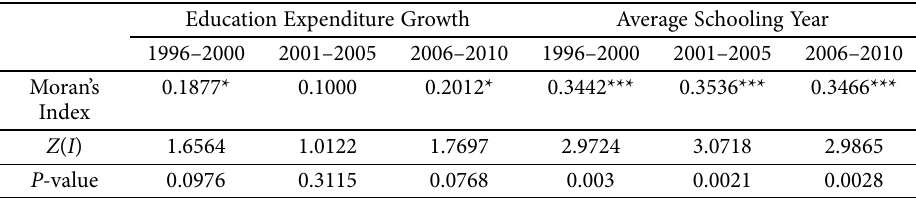
Table 2. Global Moran’s Index of education expenditure growth and average schooling year in China during 1996 and